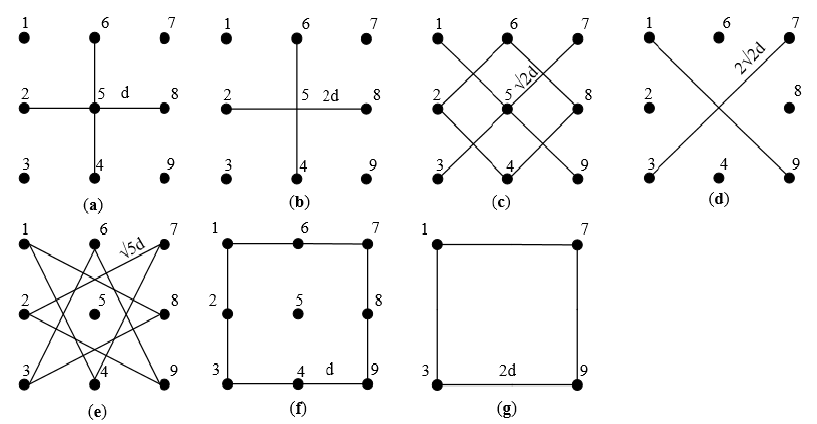
Figure 9. Schematic diagram of seven station combinations. ( a ) Combination of center and sur- rounding stations, distance is , azimuth angles are 0 ° , 90 ° , 180 ° , 270 ° ; ( b ) Combination of surround- ing stations, distance is , azimuth angles are 0 ° , 90 ° ; ( c ) Combination of center and surrounding 𝑑𝑑 stations, distance is , azimuth angles are 45 ° , 135 ° ; ( d ) Combination of surrounding stations, 2 𝑑𝑑 distance is , azimuth angles are 45 ° , 135 ° ; ( e ) Combination of surrounding stations, distance is √ 2 𝑑𝑑 , azimuth angles are 26.5 ° , 63.5 ° , 116.5 ° , 153.5°; ( f ) Combination of surrounding stations, distance 2 √ 2 𝑑𝑑 is , azimuth angles are 0 ° , 90 ° ; ( g ) Combination of surrounding stations, distance is √ 5 𝑑𝑑 angles are 0°, 90°. 𝑑𝑑